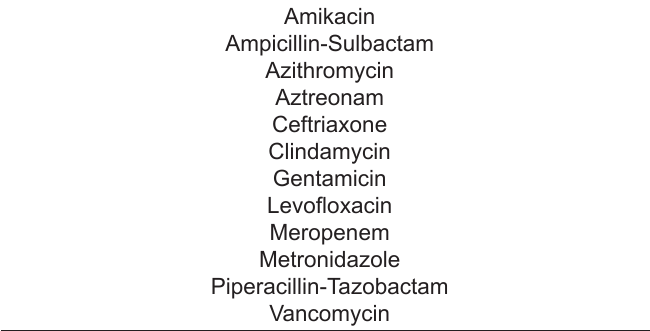
Table 1. Antibiotics available in the facility sepsis order